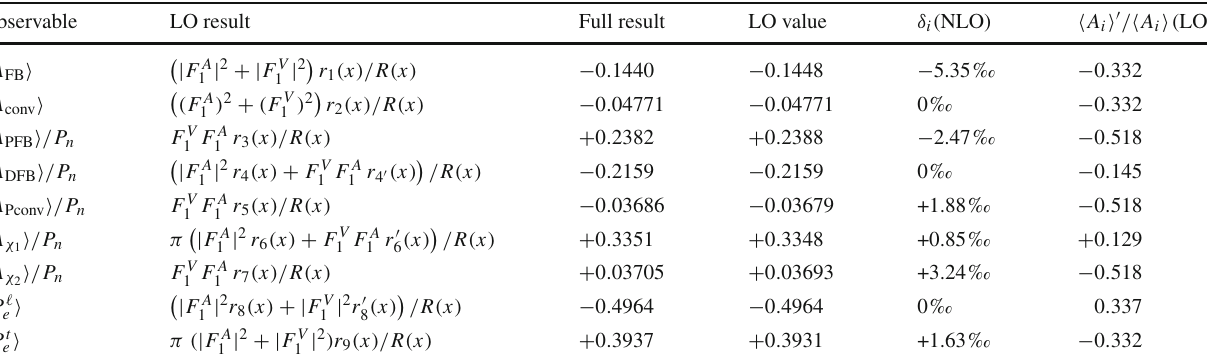
tion occurs for the forward–backward asymmetry (cid:7) F FB (cid:8) with ( NLO ) = − 5 . 35 ‰. The NLO corrections move the LO δ FB values very close to the full result in column 3 which shows that one can safely truncate the recoil expansion at NLO. directly compared to the experiment since the average asym- metry (cid:7) A PFB (cid:8) is identical to the so-called proton